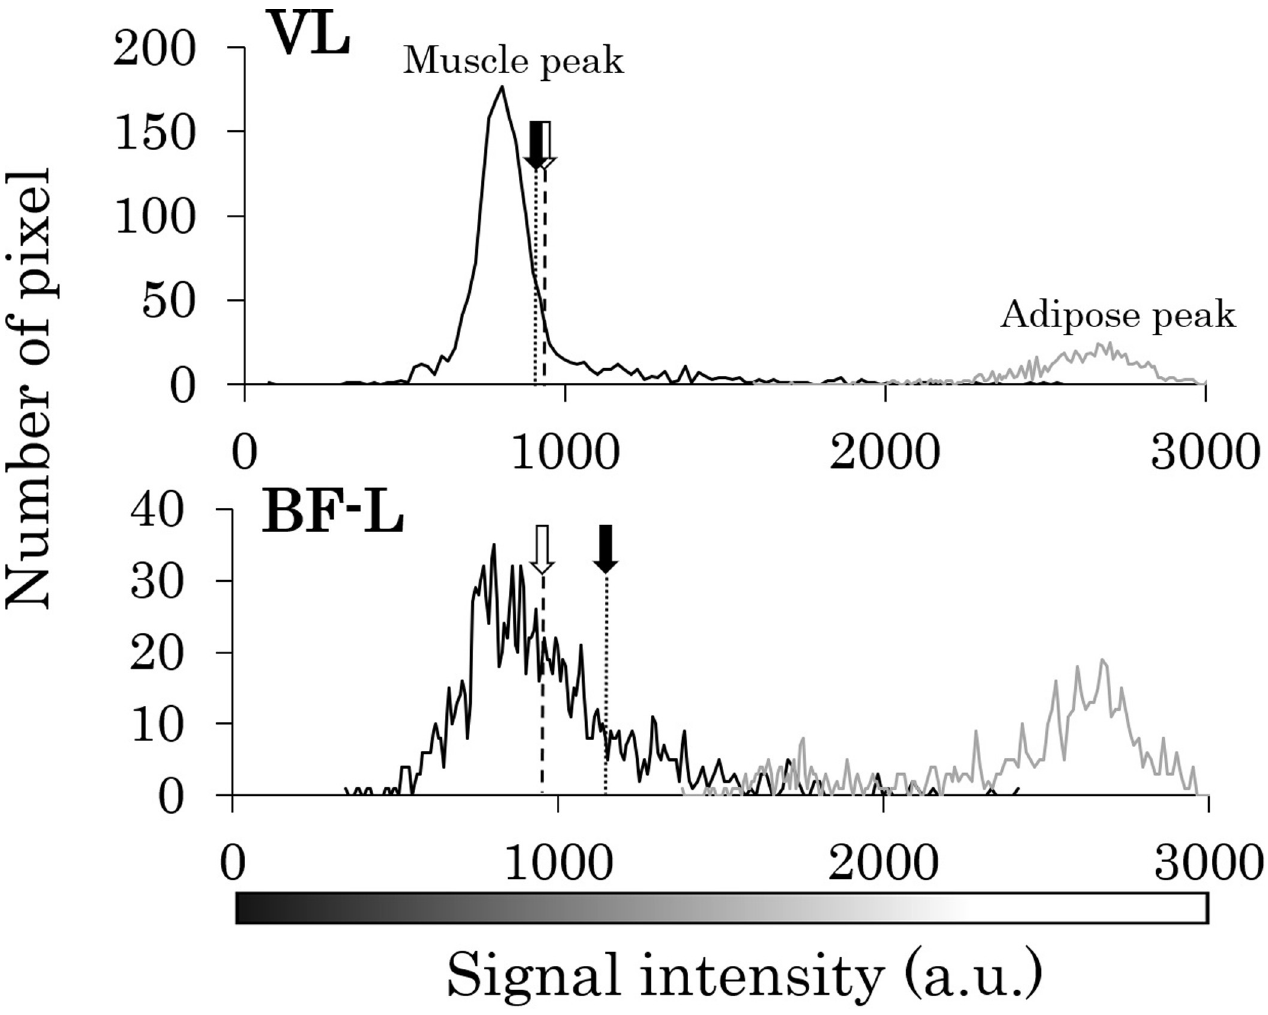
Fig 5. Representative histograms for the Vastus Lateralis (VL) and Biceps Femoris-Long head (BF-L), created based on T1-Weighted (T1W) images. T1W threshold: Threshold value of muscle and adipose tissues on T1W images. 2PD boundary value: Boundary value of muscle and adipose tissues with 2PD.